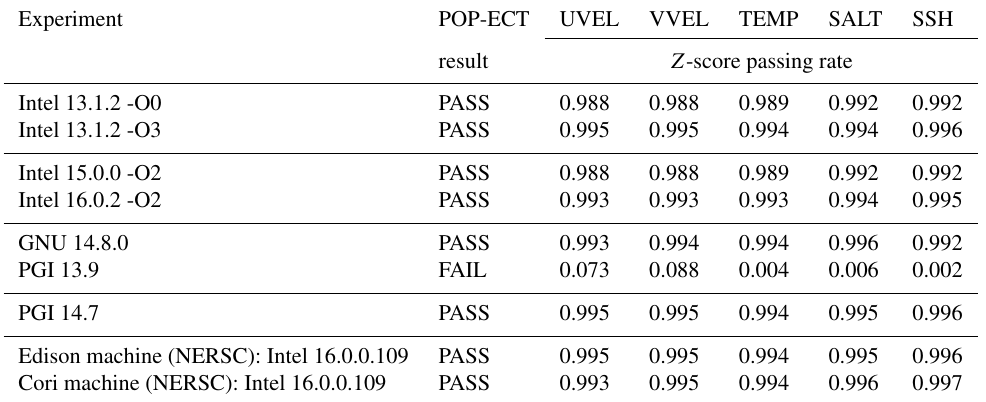
Table 1. Z -score passing rate (ZPR) for POP-ECT with default parameters t C = 12, tol Z = 3 . 0, and min ZPR = 0 . 9 for each of the five diagnostic variables (described in Sect. 3.1). Note that the top seven experiments all use NCAR’s Yellowstone machine. Experiment